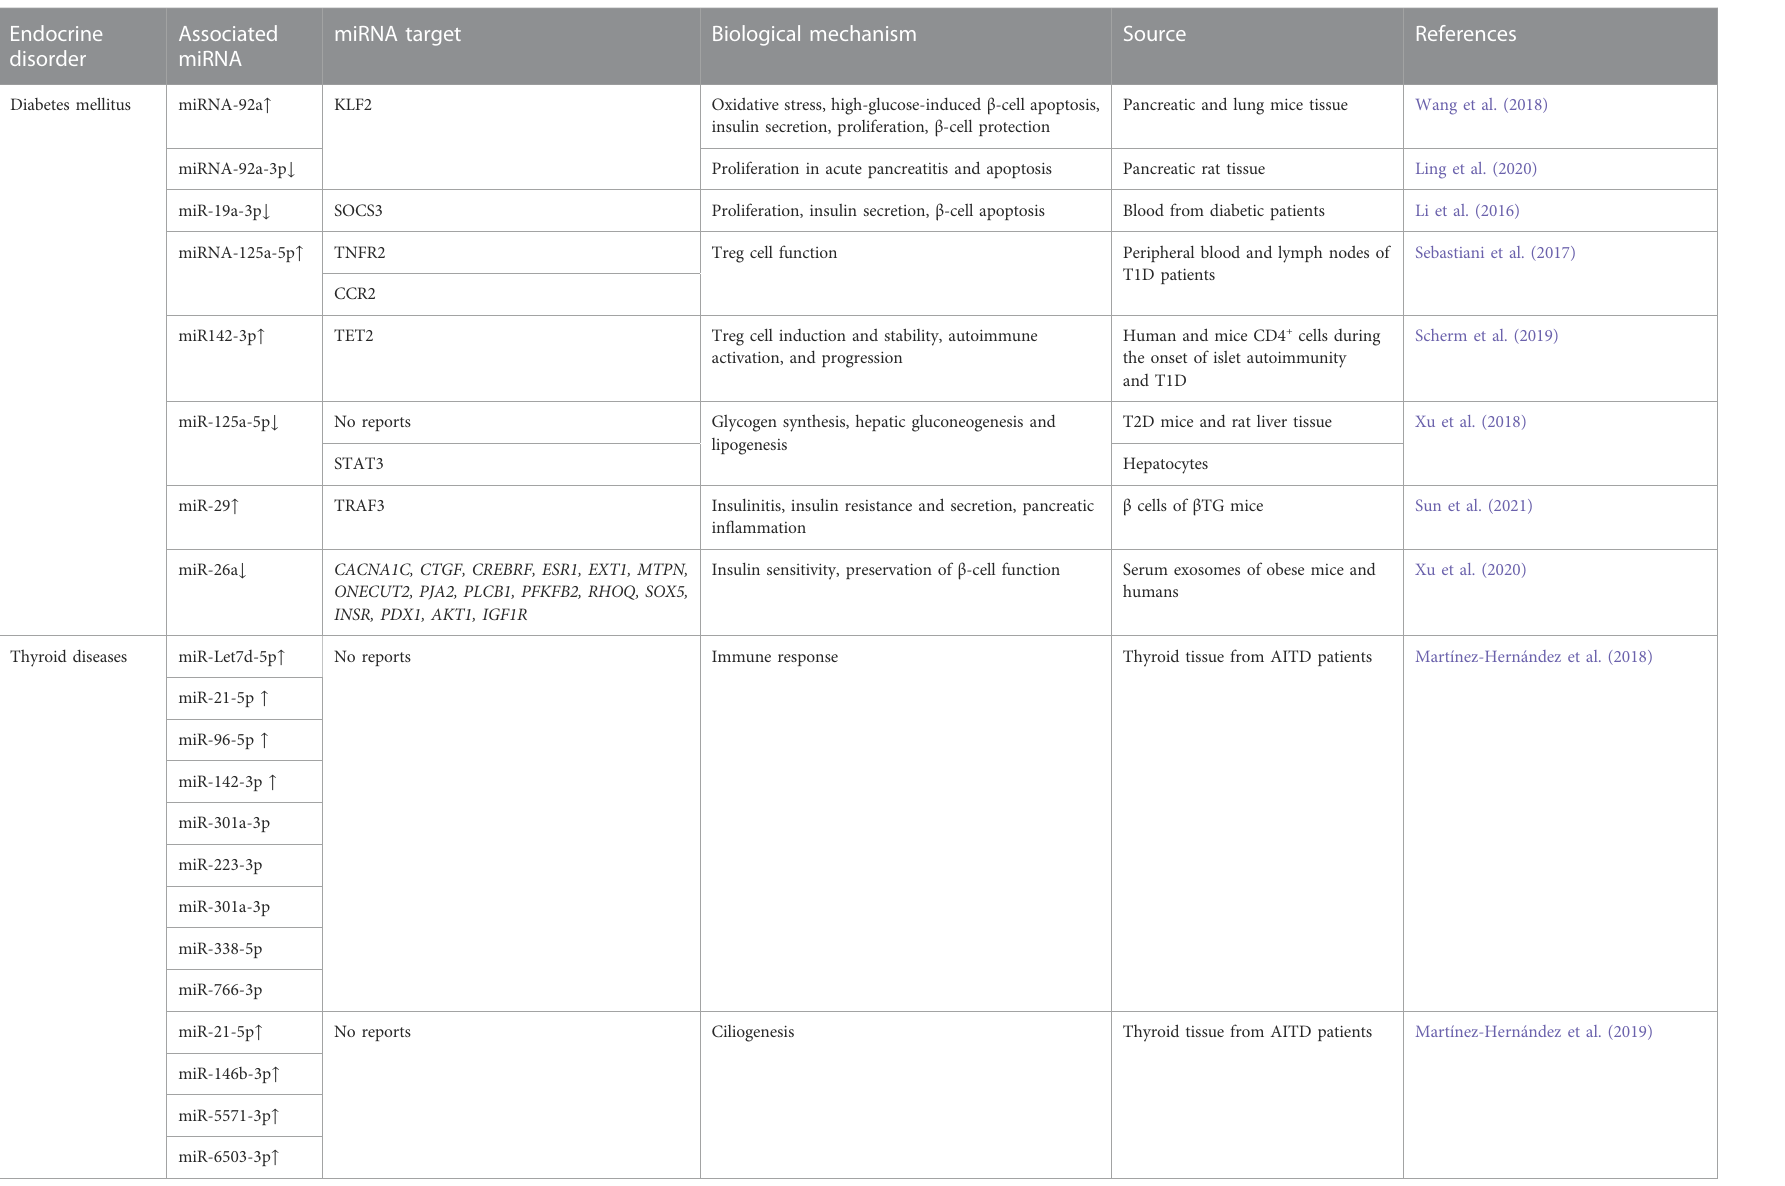
TABLE 1 Dysregulated miRNAs in endocrine